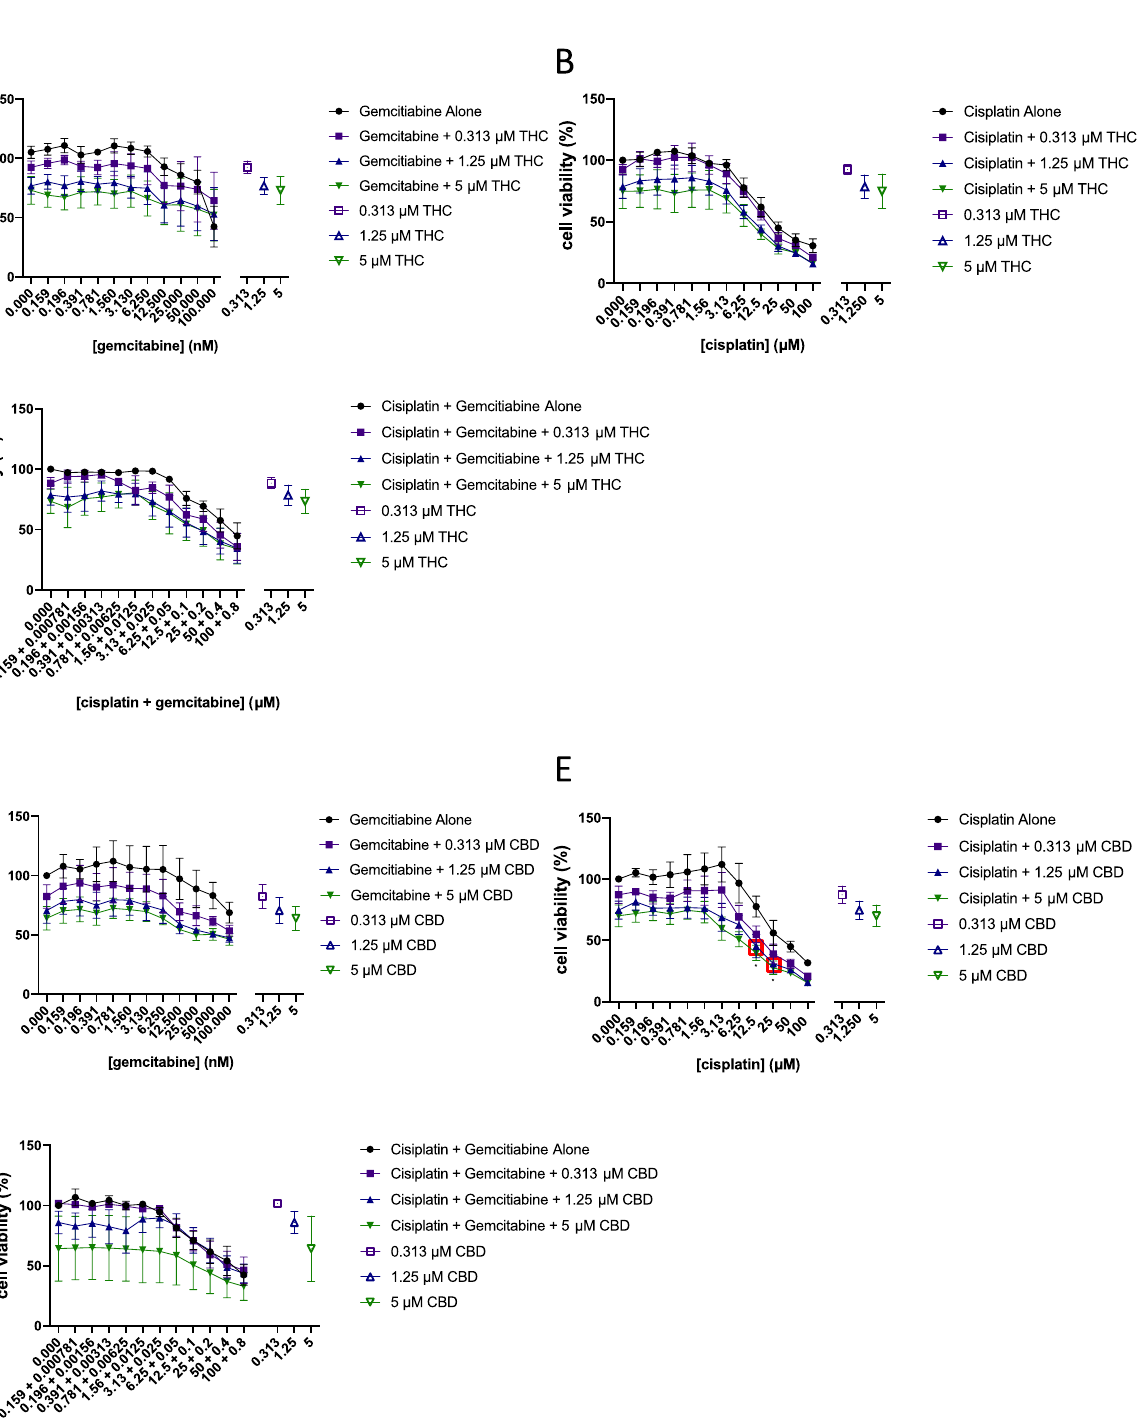
Fig. 5 Assessment of synergy between Δ 9 -tetrahydrocannabinol or cannabidiol and chemotherapeutic agents. Concentration-response curves of Δ 9 -THC or CBD combined with different concentrations of chemotherapeutic agents from the matrix are presented in T24 cells. A Gemcitabine with selected concentrations of Δ 9 -THC. B Cisplatin with selected concentrations of Δ 9 -THC. C Gemcitabine:cisplatin with selected concentrations of Δ 9 -THC. D Gemcitabine with selected concentrations of CBD. E Cisplatin with selected concentrations of CBD. F Gemcitabine:cisplatin with selected concentrations of CBD. X -axis intervals increase by a value of 2. Hollow points represent each drug’s effects alone. Red boxes indicate the concentrations where combinations of drugs were found to be synergistic as determined by the bliss independence model using SynergyFinder 2.0 software and significantly different from Δ 9 -THC, CBD, or chemotherapeutic treatment